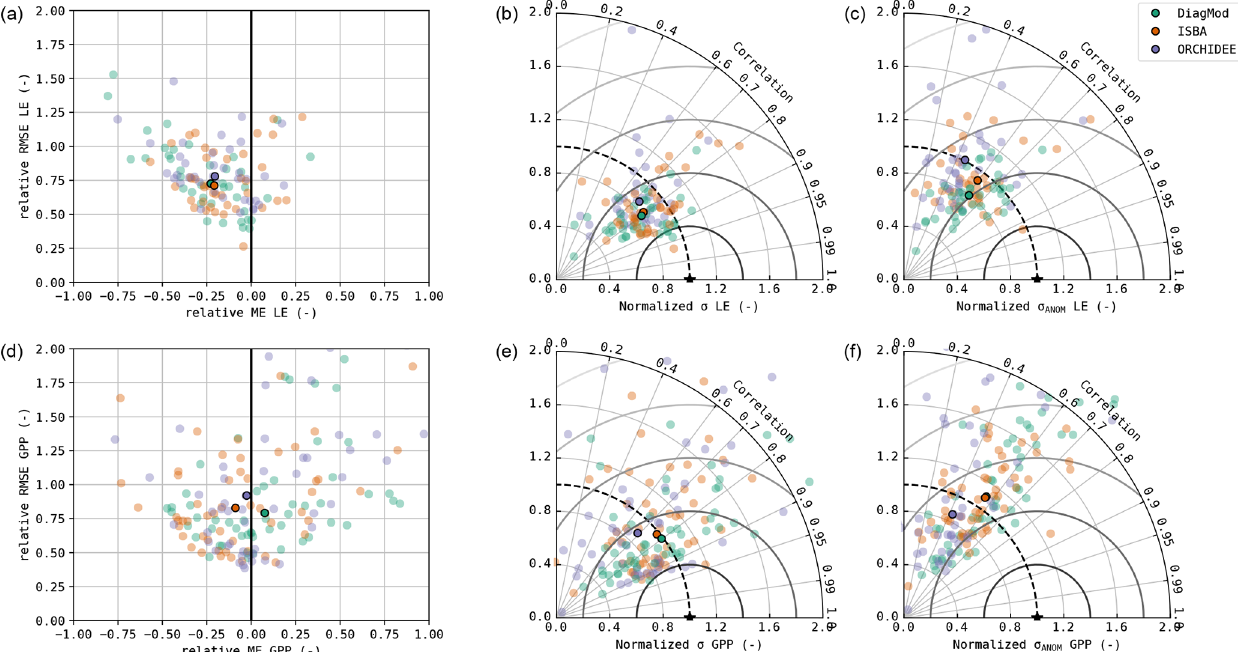
Figure 2. Accuracy plot (a, d) , Taylor diagram (b, e) and Taylor diagram of the seasonal anomalies (c, f) of the simulated daily mean LE (a–c) and GPP (d–f) . The median performance is shown with the opaque